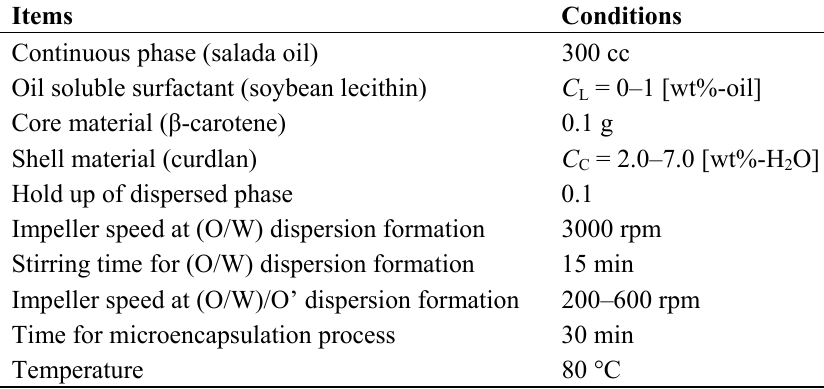
Table 1. Experimental conditions for preparation of